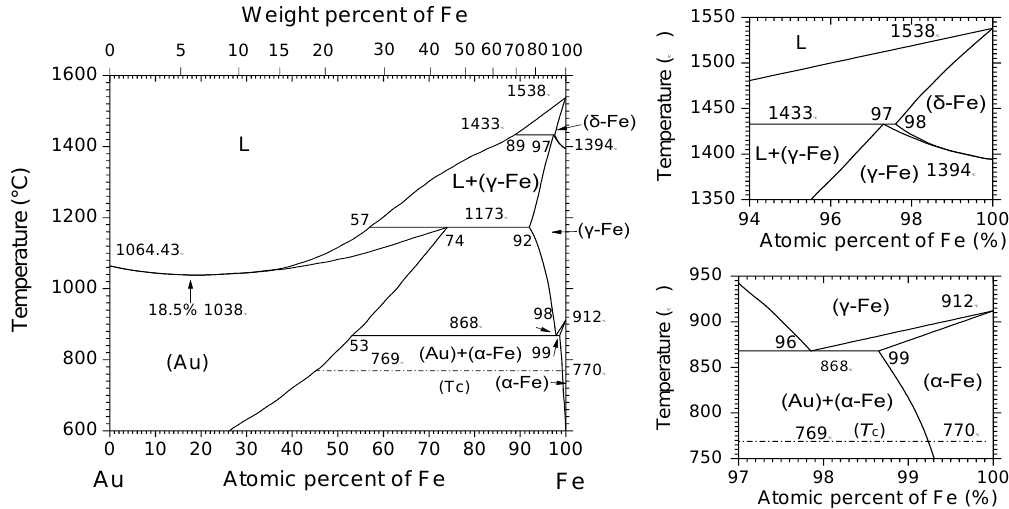
Figure 6. Phase diagram of Au-Fe binary system.